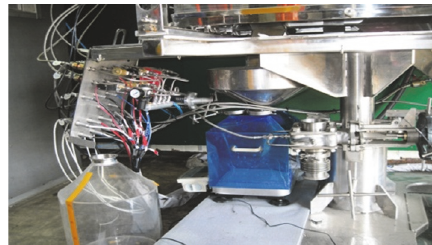
Figure 19: Hull-recovery ratio measurement equipment.